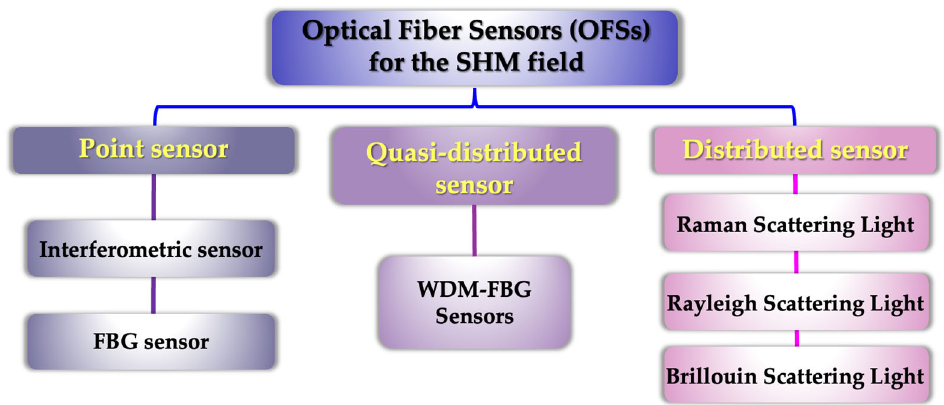
Figure 1. Overview of optical fiber sensing technologies for the SHM.